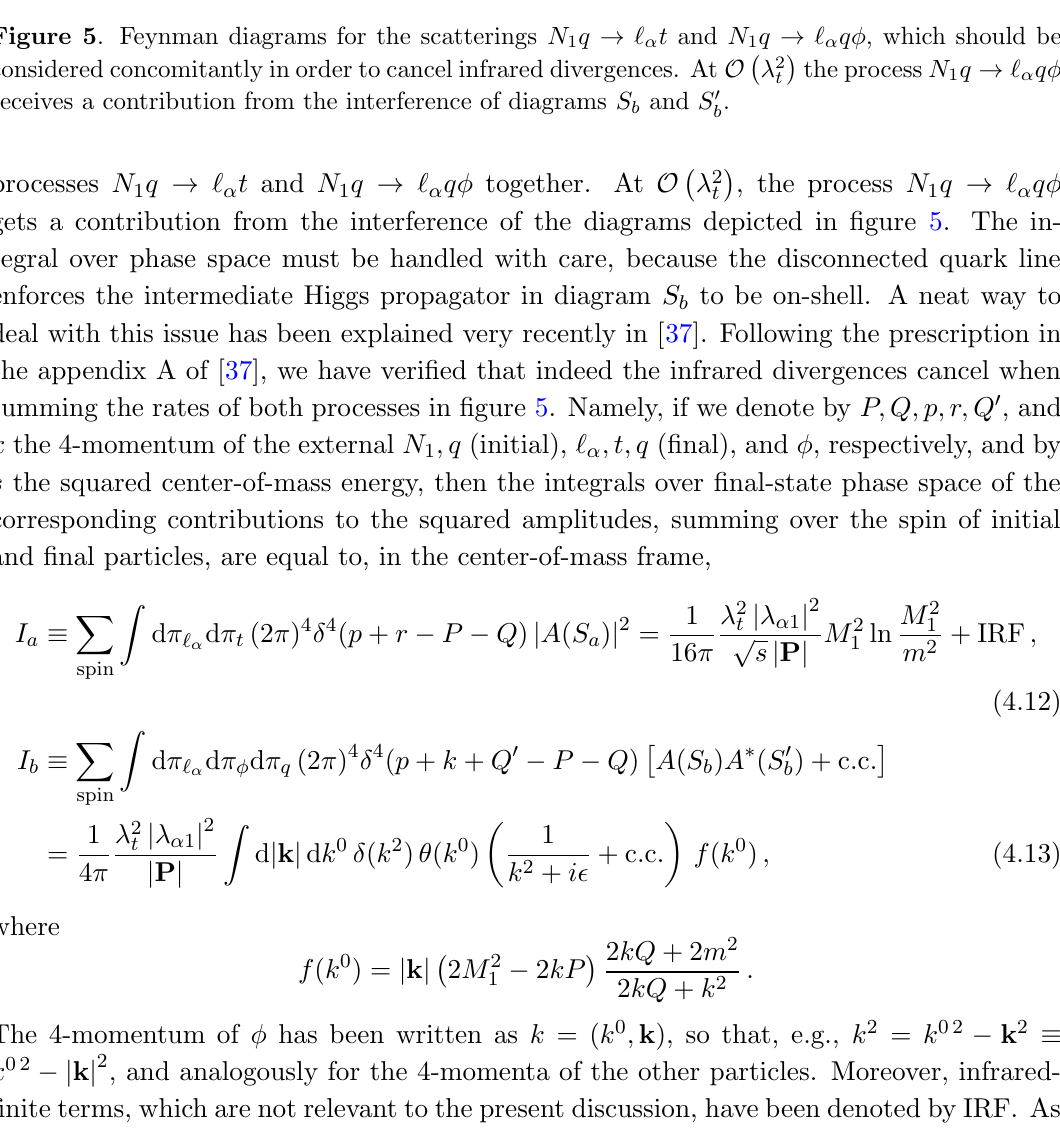
Figure 5 . Feynman diagrams for the scatterings N 1 q considered concomitantly in order to cancel infrared divergences. At receives a contribution from the interference of diagrams S b and S 0